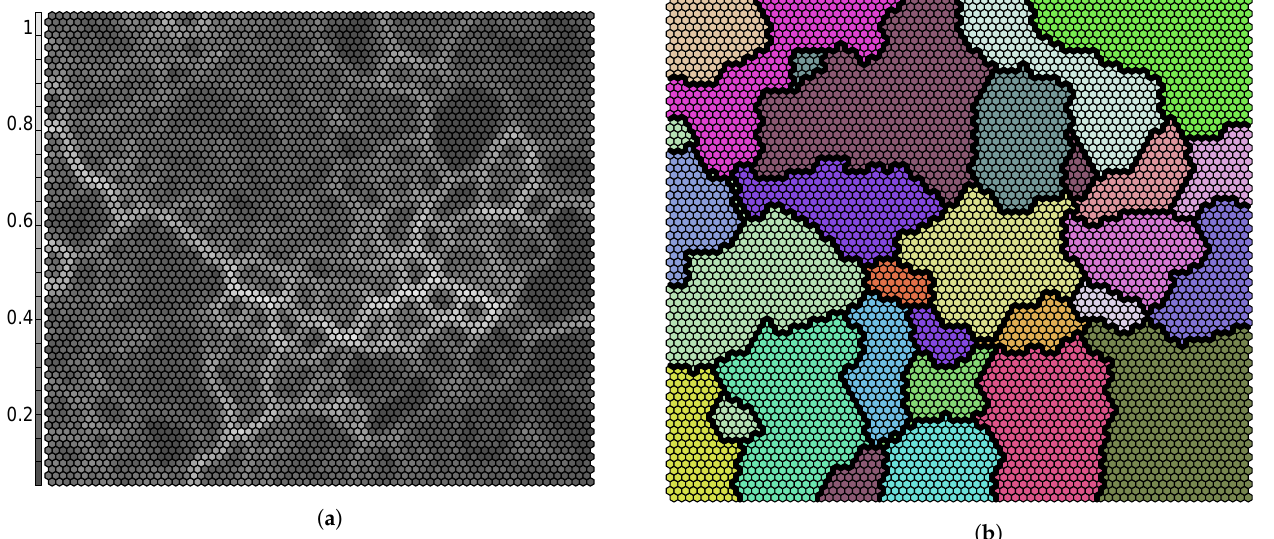
Figure 5. The U-Matrix and the clustering of the codebook vectors of the SOM, trained on all 30 independent runs of 243 bench- mark functions. ( a ) U-Matrix; ( b ) Clustering of the codebook